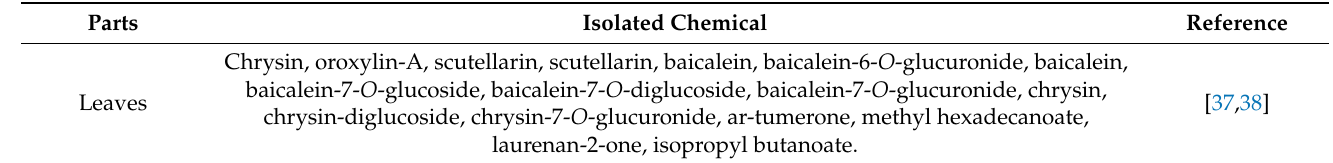
Table 3. Different active chemicals isolated from various parts of Oroxylum